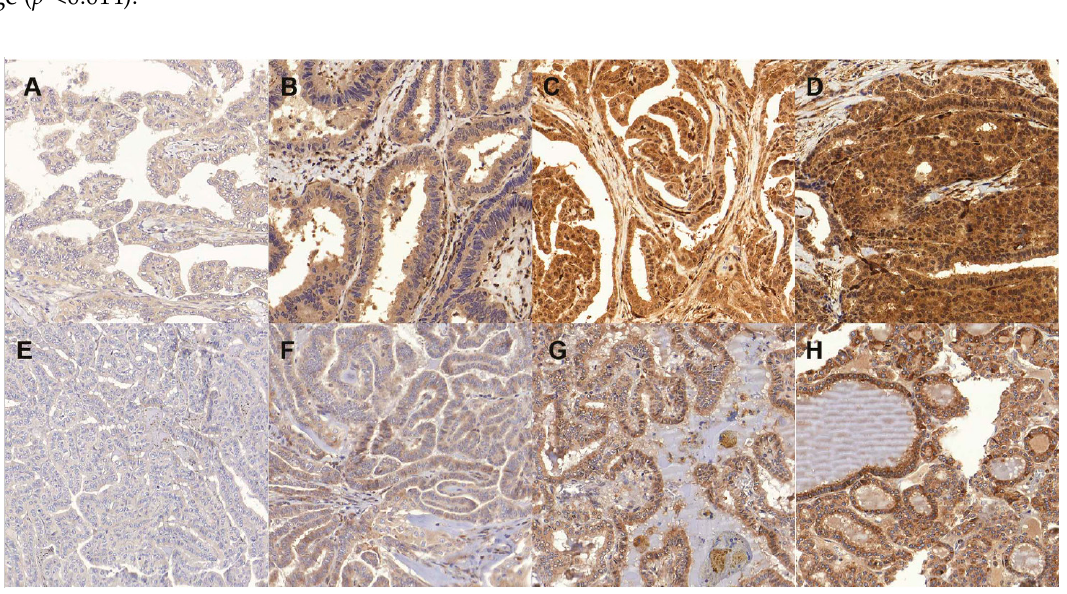
Figure 1. Immunohistochemical expression of PTEN ( A negative, B weak; C moderate, D strong) and